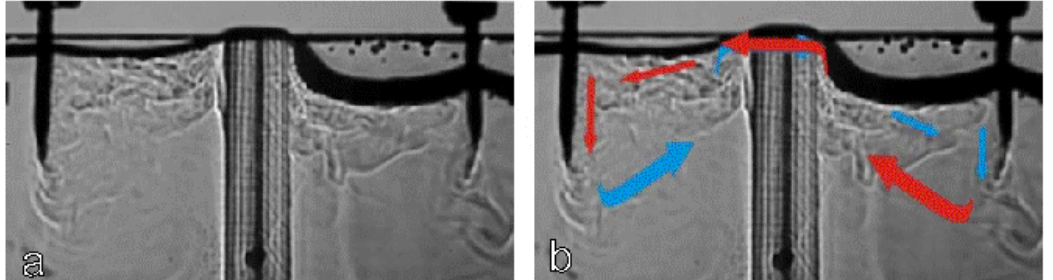
Figure 11. Schlieren image of the flow inside the dual beaker configuration (a). In (b) arrows are added to demonstrate the lemniscate shaped flow from anode to cathode (red) and back (blue) (from